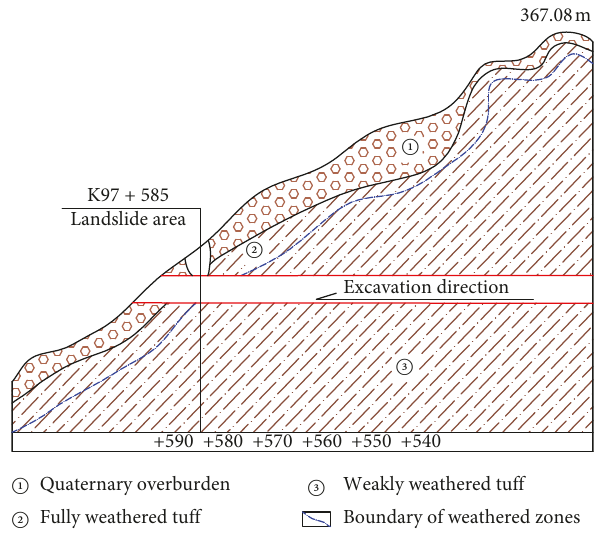
Figure 5: Slope geography and rock soil distribution. Table 3: Relevant calculation